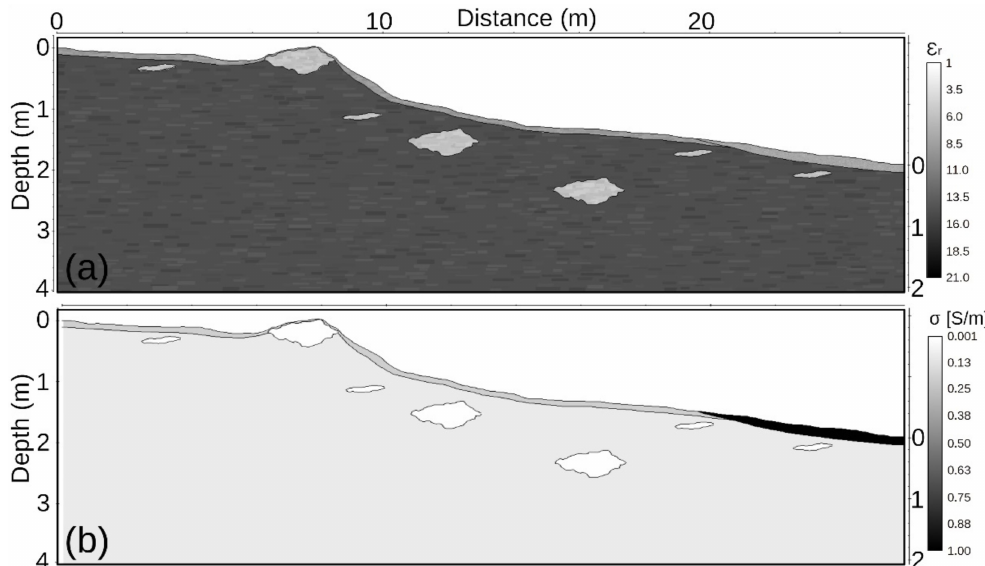
Figure 7. Second model, with a high level of complexity thus closer to field site conditions: It includes real topography, perturbations of physical properties and increased conductivity of shallower layers (parameters in Table 4); ( a ) model displaying the relative dielectric permittivity properties assigned to media, with statistical variations; ( b ) same model displaying the conductivity values assigned to media.